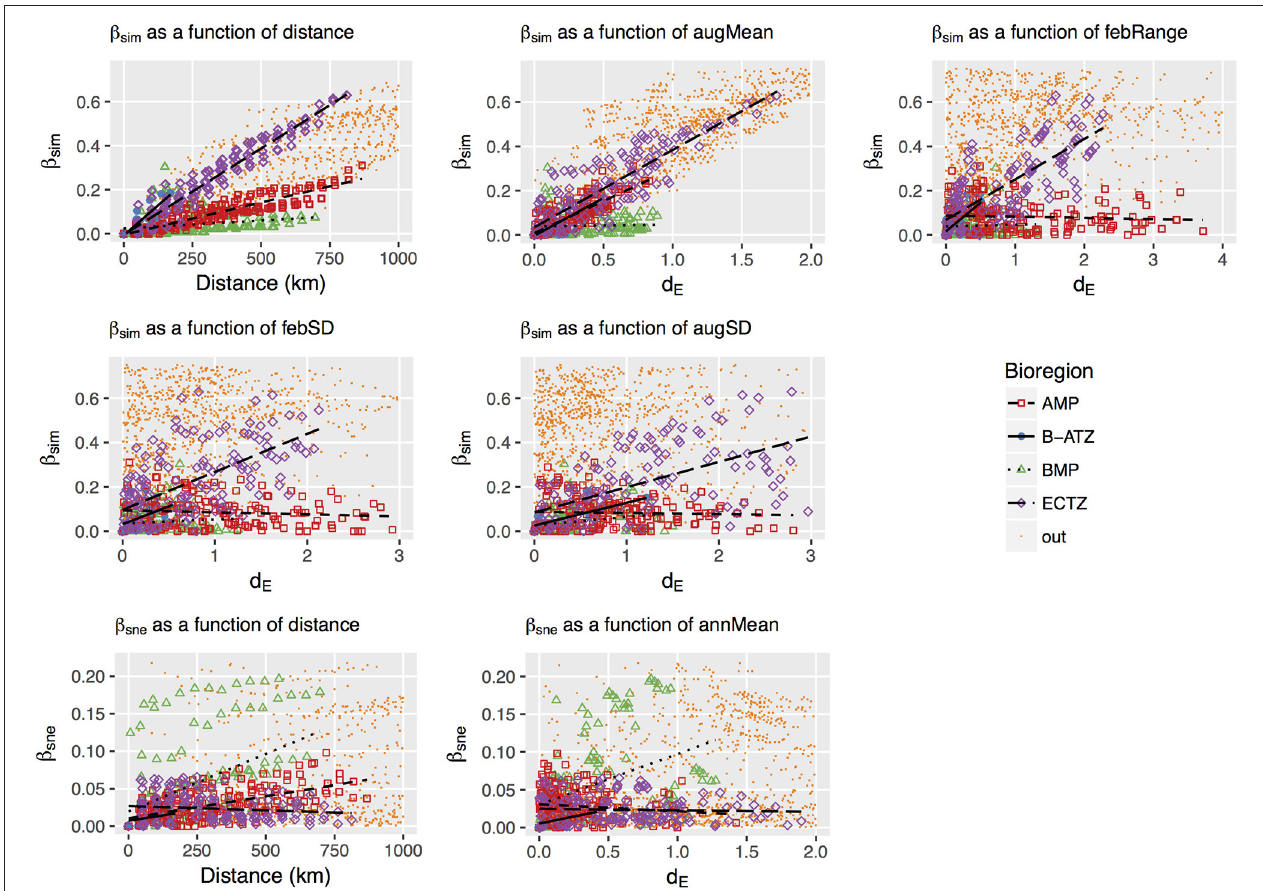
FIGURE 5 | Plots of the turnover ( β sim ) and nestedness-resultant ( β sne ) forms of β -diversity as a function of geographical or thermal distance between the coastal sections. The influential d E variables ( augMean , febRange , febSD and augSD for β sim , and annMean for β sne ) were determined in the db-RDA procedure. β sim , β sne , d E and geographical distance were calculated as differences between coastal section pairs, and data points representing section pairs falling between bioregions are colored yellow and labeled “out.” The strengths and gradients of the regression lines indicated in the panels are presented in Table 3